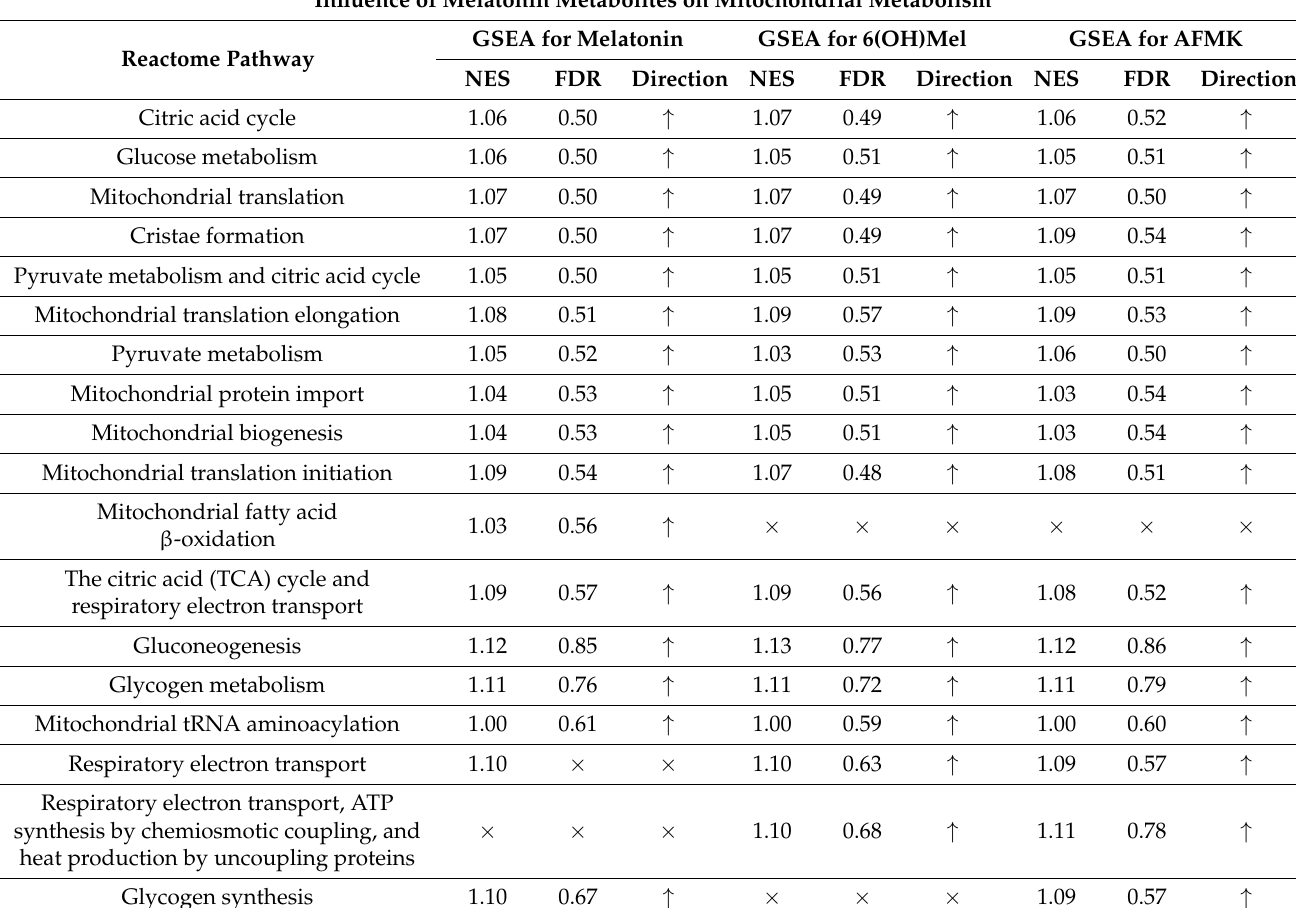
Table 3. GSEA for mitochondrial metabolism/signaling in primary human epidermal keratinocytes treated with melatonin, 6(OH)Mel or AFMK; NES—Normalized Enriched Score; FDR—False Discovery Rate; ( × )—the effect is absent. Influence of Melatonin Metabolites on Mitochondrial